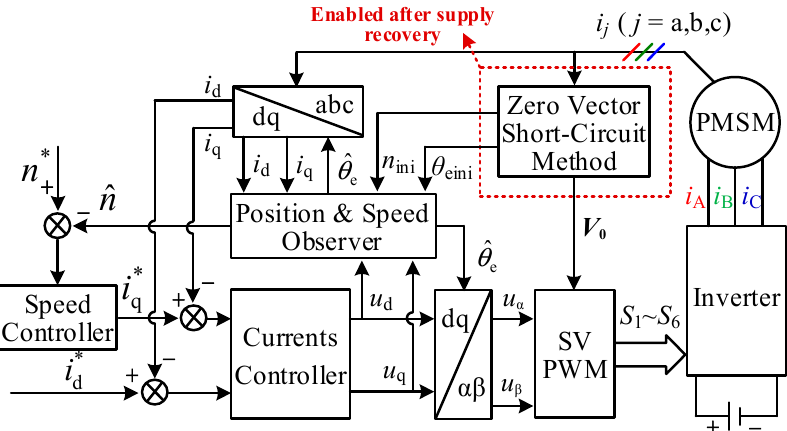
Figure 1. Diagram of sensorless PMSM flying restart control scheme based on the ZVSM.